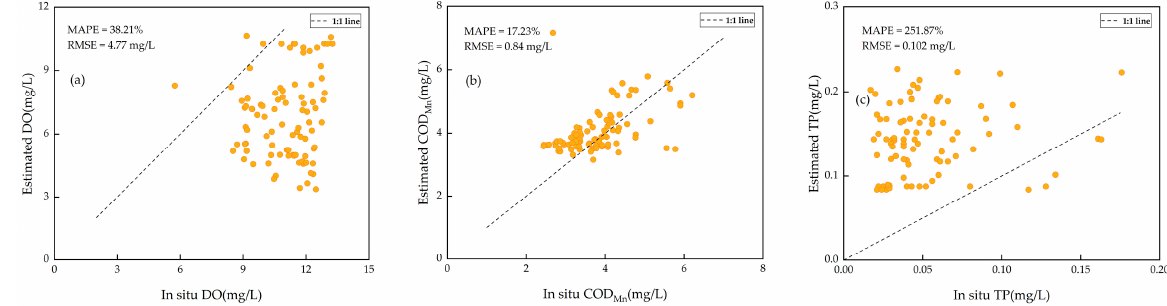
Figure 11. Comparison between AHSI R rs -derived and in situ DO ( a ), COD Mn ( b ), and TP ( c